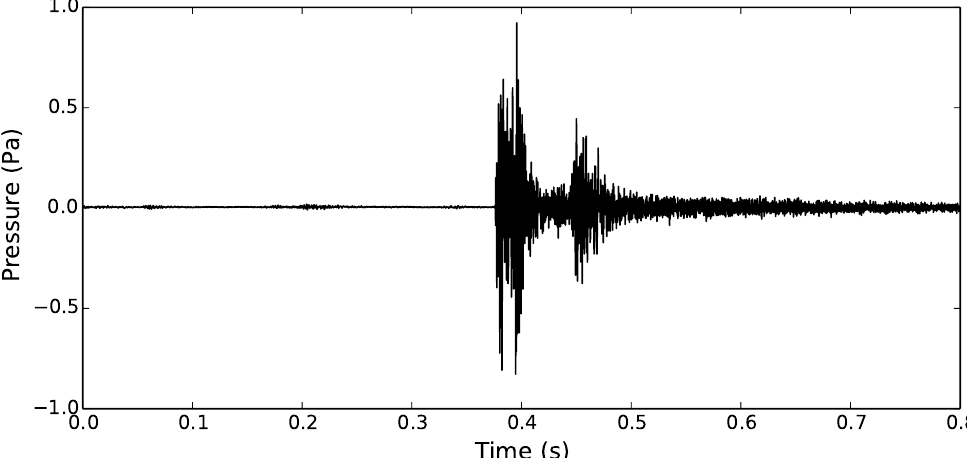
Figure 10. Time recording of one calibrated stroke at a distance of 1 m from the pneumatic sensor being